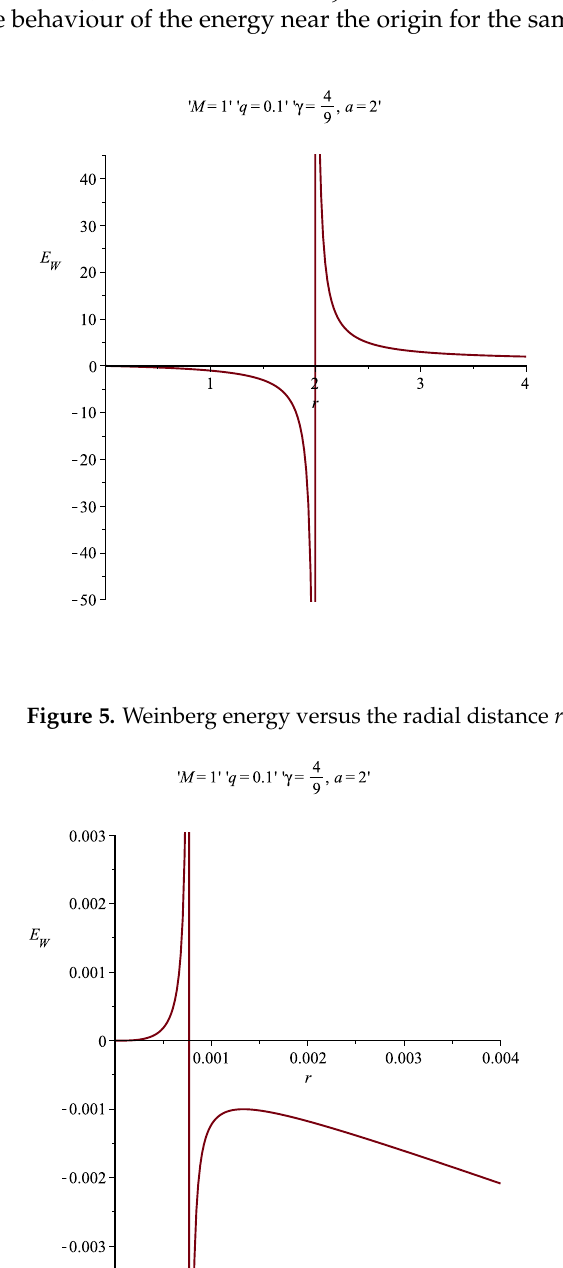
Figure 6. Weinberg energy versus the radial distance r near the